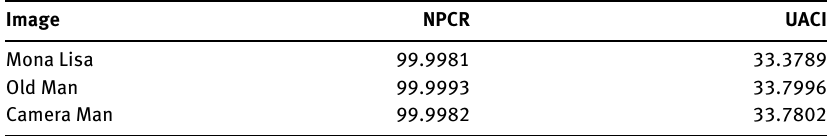
Table 3: The NPCR and UACI Result Values.